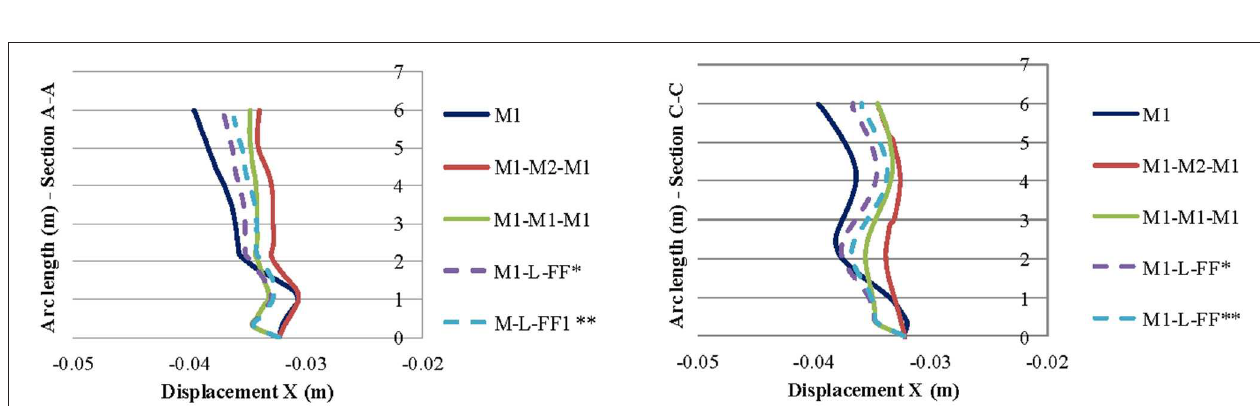
Frontiers in Built Environment |